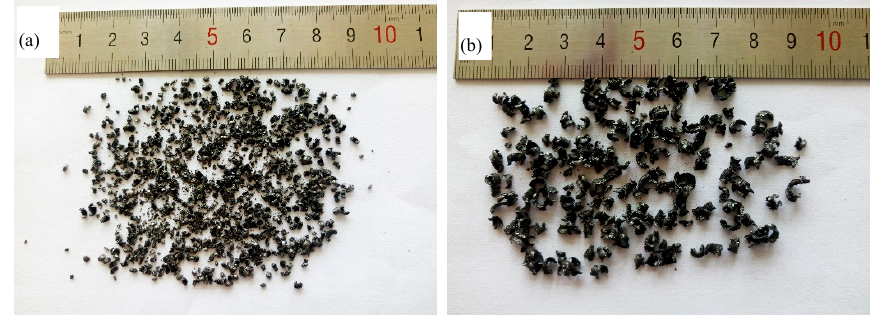
Figure 7. The turning chips appearance at 2 mm cutting depth: ( a ) HT250 and ( b ) QT450.